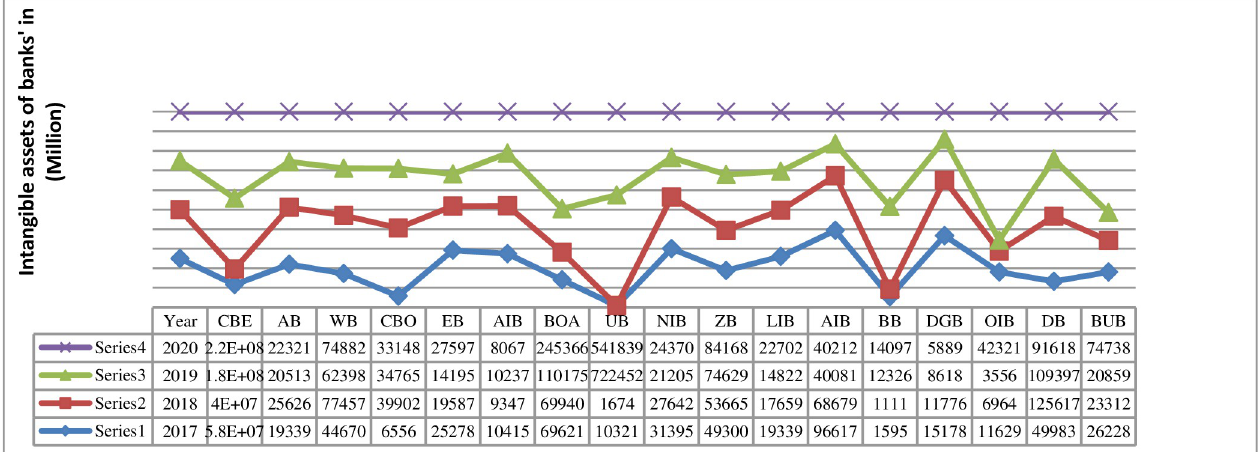
Fig 2. Trend of intangible assets of seventeen (17) commercial banks’ in Ethiopia. Source: Own computation 2021.